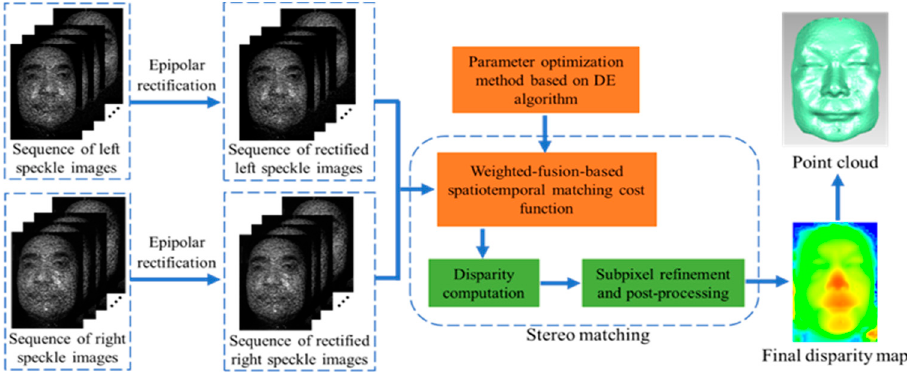
Figure 2. Schematic diagram of the proposed random speckle 3D reconstruction scheme.